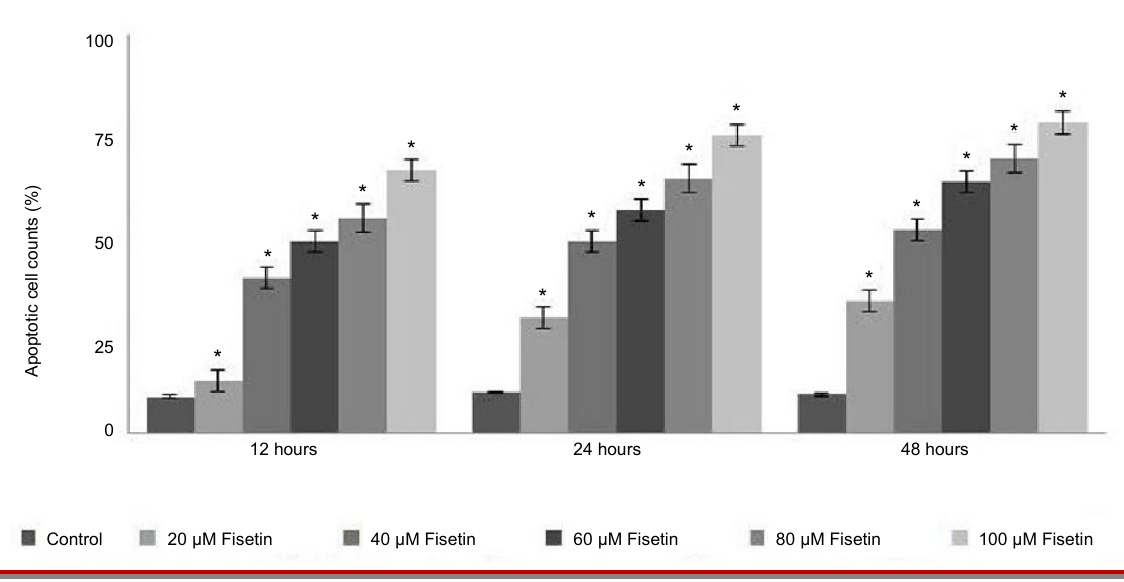
Figure 2: Influence of fisetin on apoptotic cell counts Fisetin induced apoptosis of the U-2 OS cells in a dose-dependent manner as determined by Annexin V staining. Values are represented as mean ± SD; n=3; *represents p<0.05 compared with control as determined by one